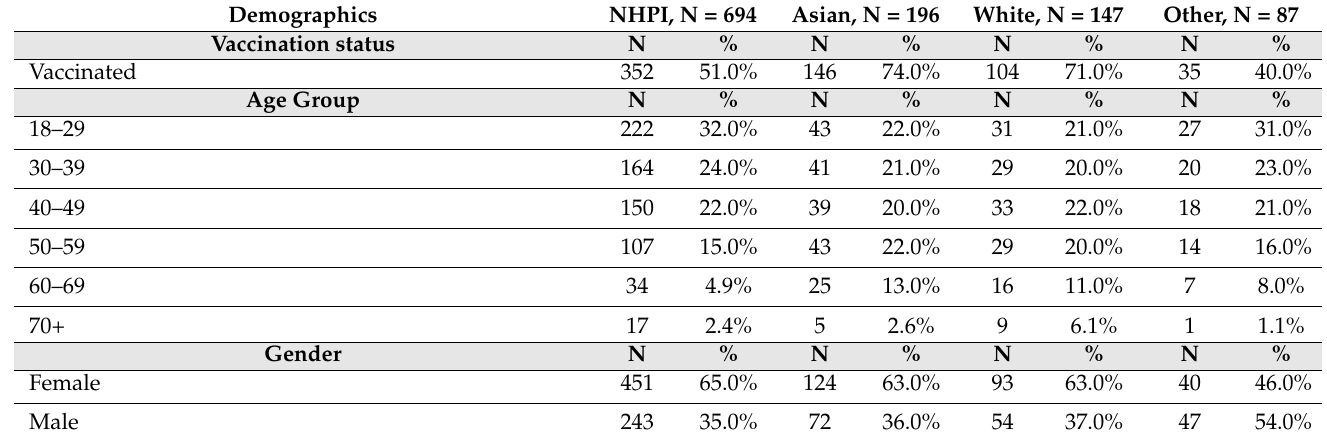
Table 2. Summary statistics of responses to RADx-UP survey broken down by